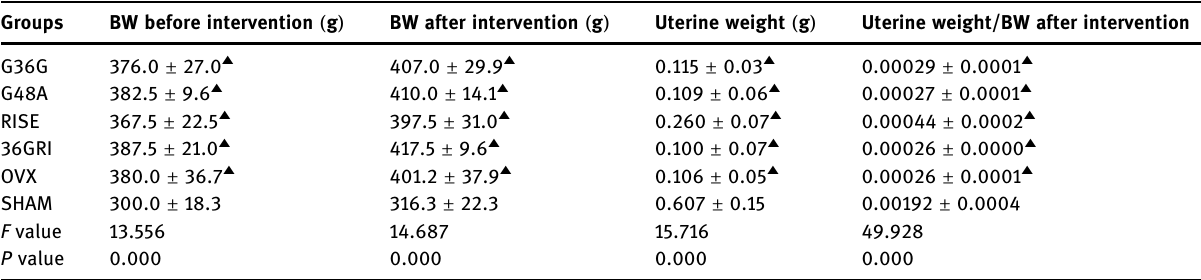
Table 1: The BW and uterine weight of rats in di ff erent intervention groups before and after interventions ( x s ¯ ± )